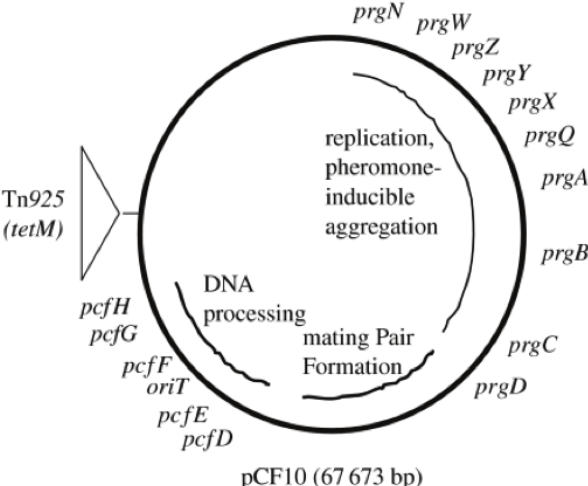
Figure 2: pCF10 plasmid map